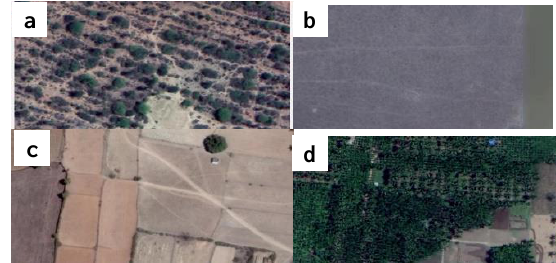
Figure 7 Output from Dense Based Method